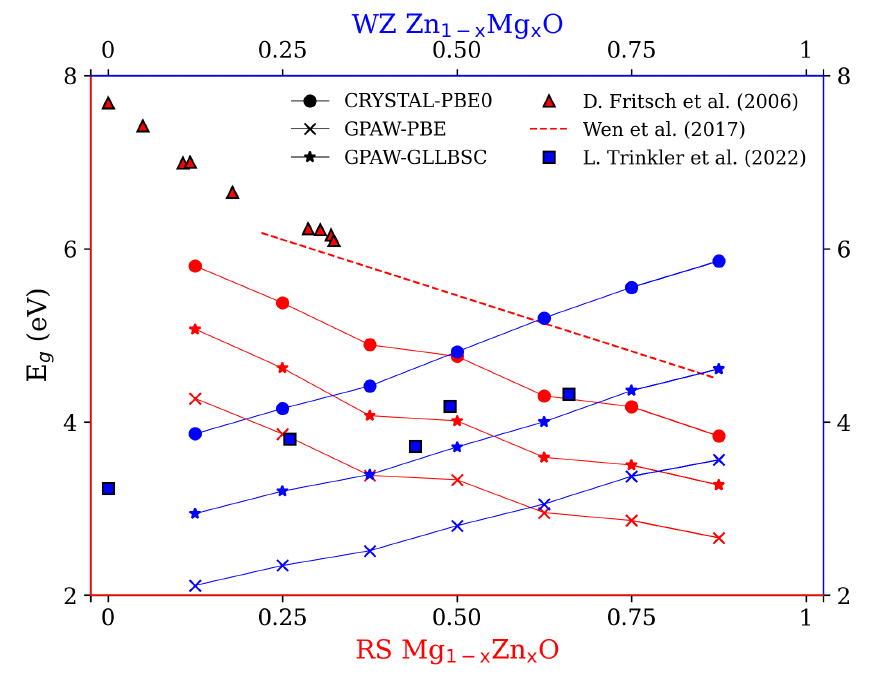
Figure 2. Band gaps ( E g ) for rocksalt (RS) Mg 1 − x Zn x O and wurtzite (WZ) Zn 1 − x Mg x O for x = 0.125, 0.25, 0.375, 0.5, 0.625, 0.75 and 0.875. The blue color is WZ phase; the red color is RS phase. The symbols of circles, crosses and stars represent the E g calculated by PBE0 with CRYSTAL17, PBE+U with GPAW and GLLBSC+U with GPAW, respectively. The red triangles and blue squares stand for the experimental values for RS ZMO alloys [39] and WZ ZMO epilayers [7]. The red dashed line is the fitting relation between E g and concentrations of RS Mg 1 − x Zn x O ranging from x = 0.22 to 0.87 based on the experimental values of E g (RS Mg 1 − x Zn x O) = 4.17 + 2.58(1 − x) (eV)